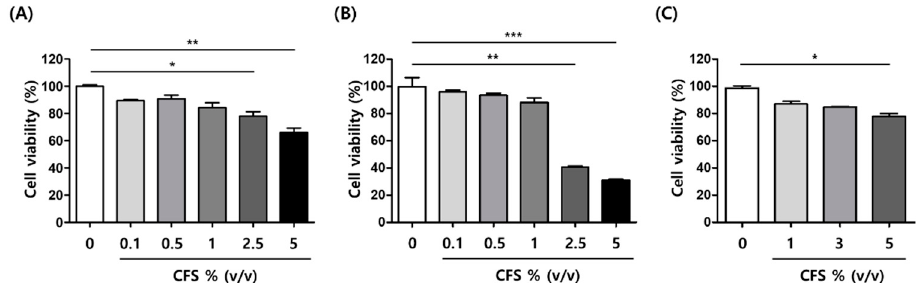
Figure 1. Effect of CFS on B16-F10 and HaCaT cell viability. B16-F10 cells were treated with various concentrations of CFS for ( A ) 24 h and ( B ) 48 h. ( C ) HaCaT cells were treated with various concentrations of CFS for 24 h. Cell viability was assessed by WST-1 assay. CFS: cell-free supernatant from L. gasseri BNR17. Values represent the mean ± SD of three independent experiments. * p < 0.05, ** p < 0.01, and *** p < 0.001 for control versus sample.